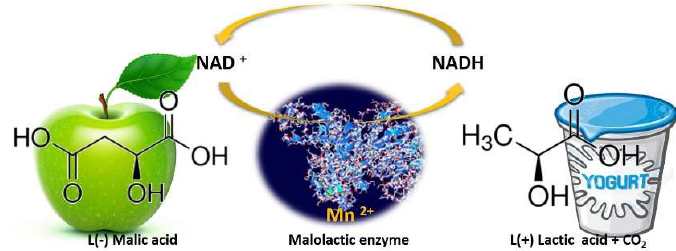
Figure 3. Schematic representation of malolactic enzyme action. Malolactic bacteria convert sharp green-apple-like malic acid into softer, much less tart lactic acid, releasing CO 2 along the way.